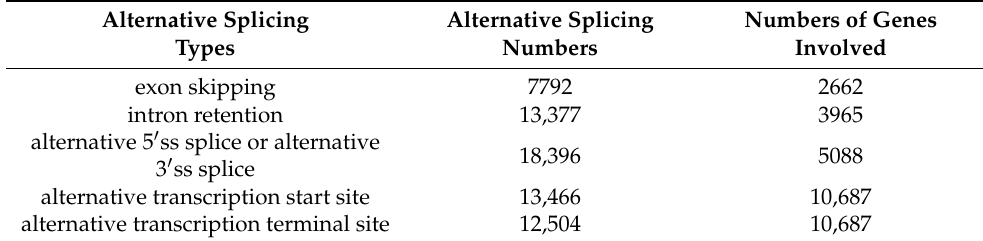
Table 1. Statistics of alternative splicing of RNA-seq